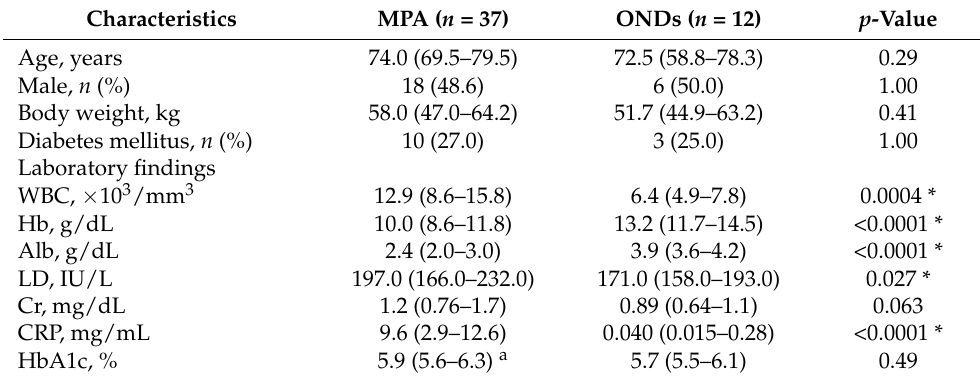
Table 2. Comparison of clinical characteristics between patients with MPA and patients with